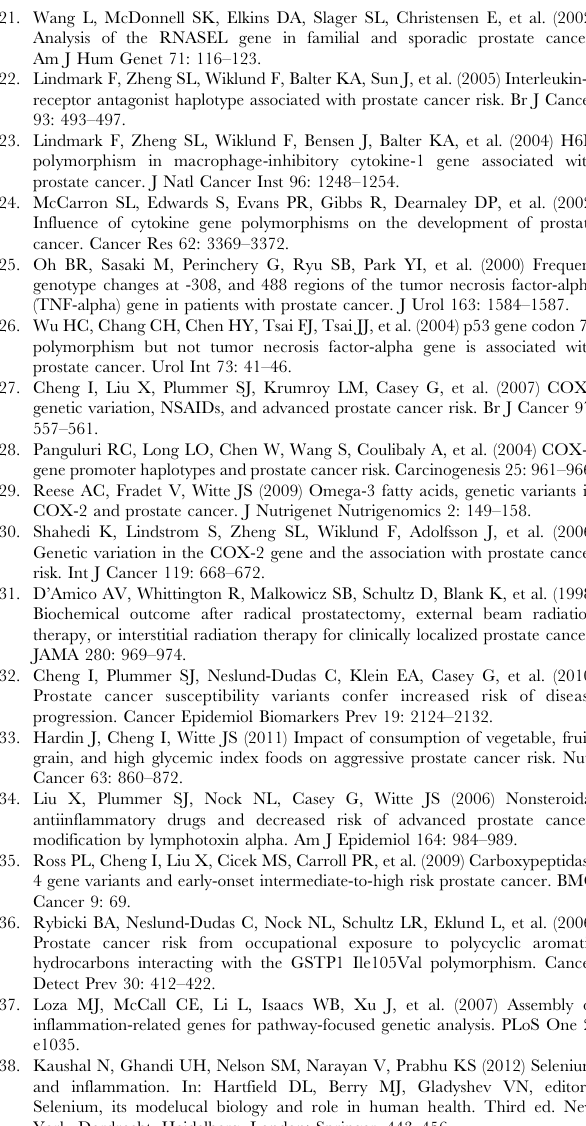
Table S1 Description of the 320 single nucleotide polymor- phisms analyzed. A1: Minor (rarer) allele; A2: Other (frequent) allele; A1A1: Rarer homozygous genotype; A1A2: Heterozygous genotype; A2A2: Frequent homozygous genotype; MAF: Minor